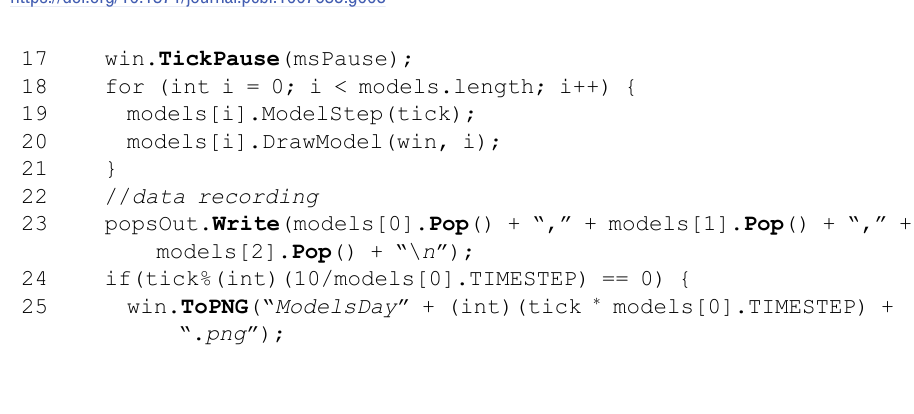
Fig 8. ( A ) Example program flow diagram. Bold font indicates where coding example sections are first called. ( B ) CellStep function flow diagram.